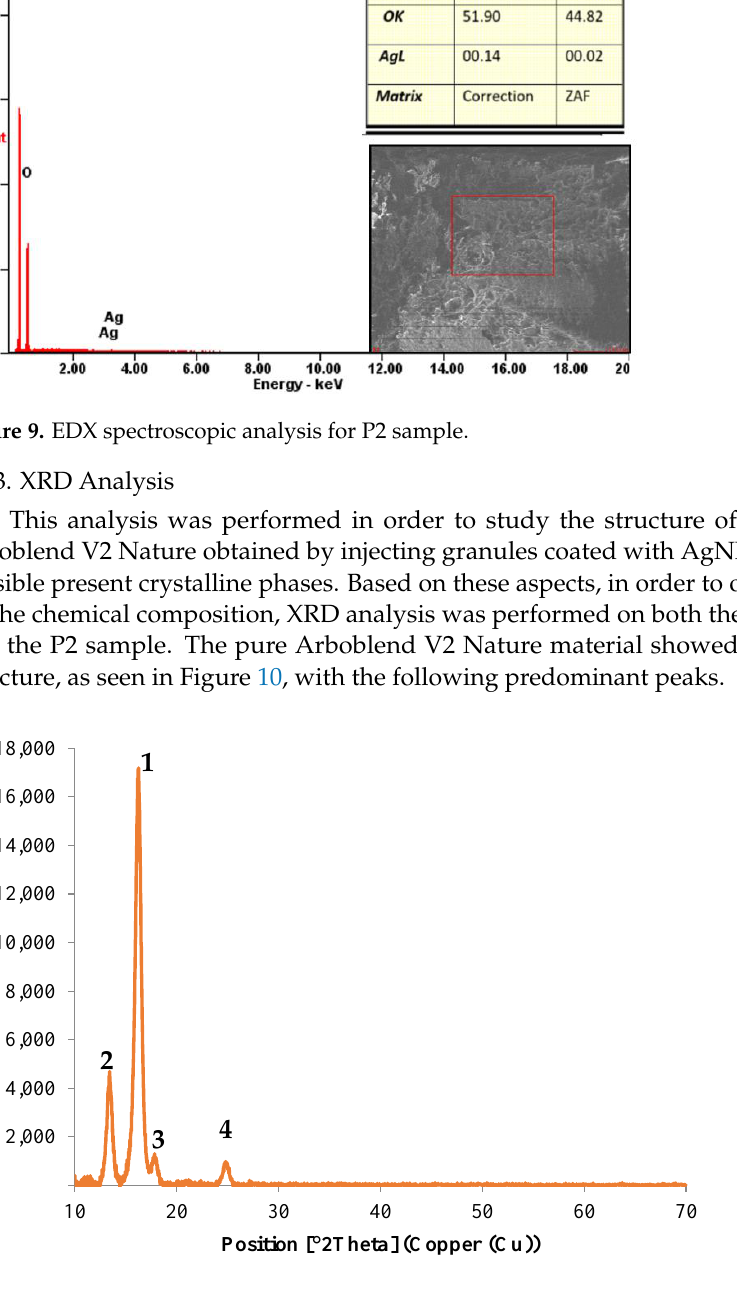
Figure 10. XRD analysis of the uncovered sample of Arboblend V2 Nature.